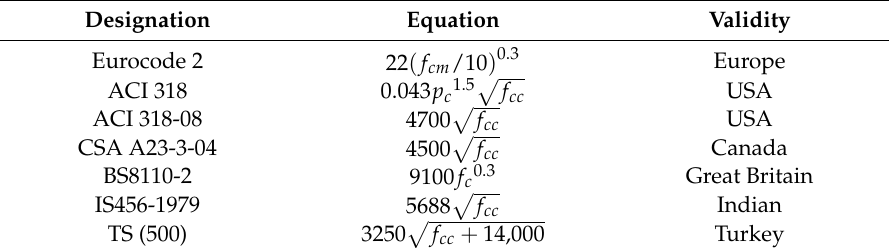
Table 7. Some empirical relations for predicting concrete modulus elasticity.